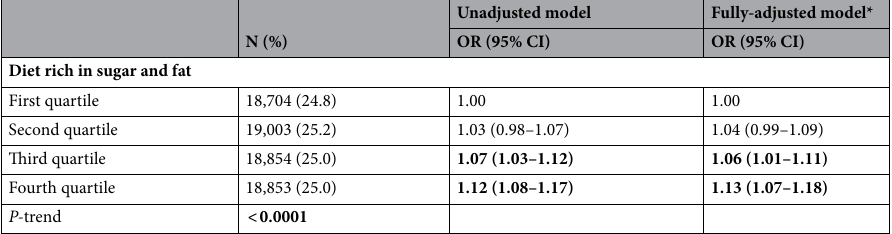
Table 5. Association between high physical exertion at work and diet rich in sugar and fat at 5 years of follow-up among employees in the CONSTANCES cohort study, 2012–2018 (odds ratios (ORs), and 95% confidence intervals, CI). Significance values are given in bold. *Adjusted for age (years, continuous), sex, occupational grade (low; medium; high), depressive symptoms at baseline (no; yes), educational level (levels, continuous), household income (€/month, continuous) and baseline level of